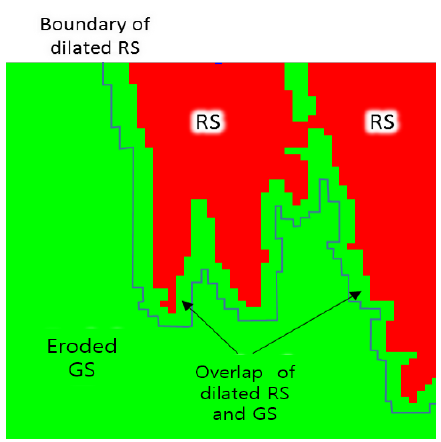
Figure 5. Dilated red segment (RS) and eroded green segment (GS).